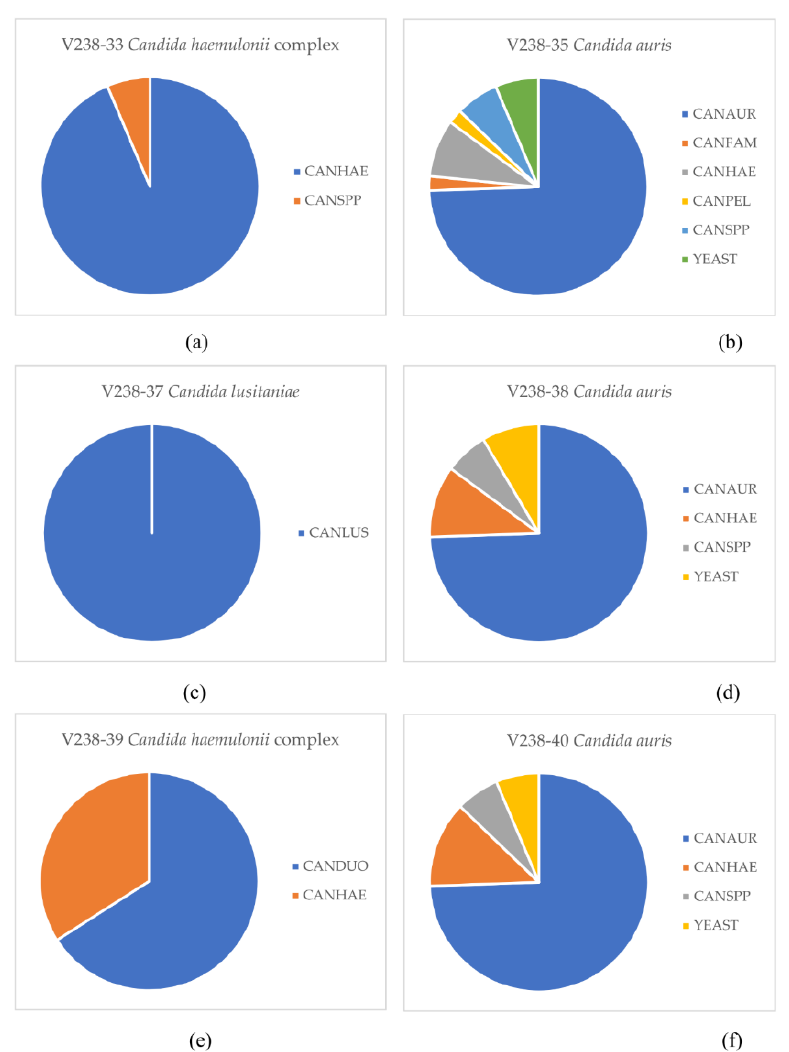
Figure 1. Identifications provided by 46 Dutch clinical microbiology laboratories for a panel of six Candida isolates. ( a ) C. haemulonii complex (containing both C. haemulonii and C. pseudohaemulonii ); ( b ) C.